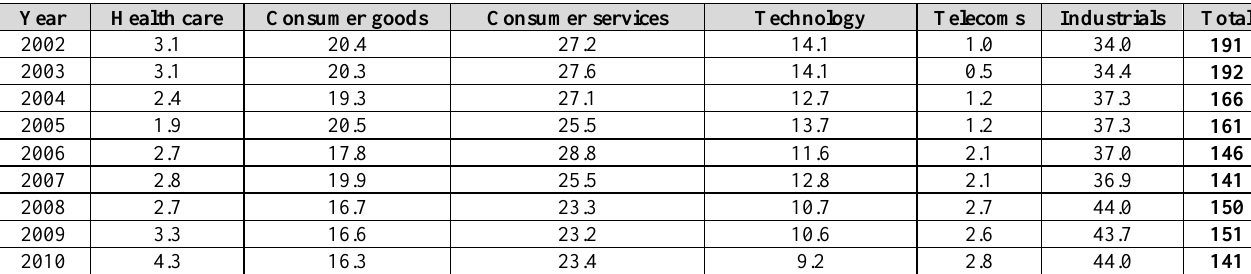
Table 2: Summary of the considered companies (% of total sample)